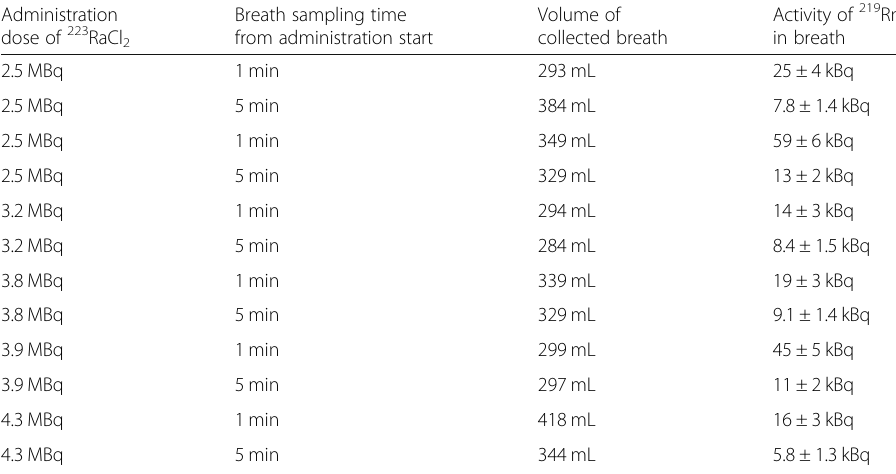
Table 1 Summary of the amounts of 219 Rn contained in breath samples from patients treated with 223 RaCl 2